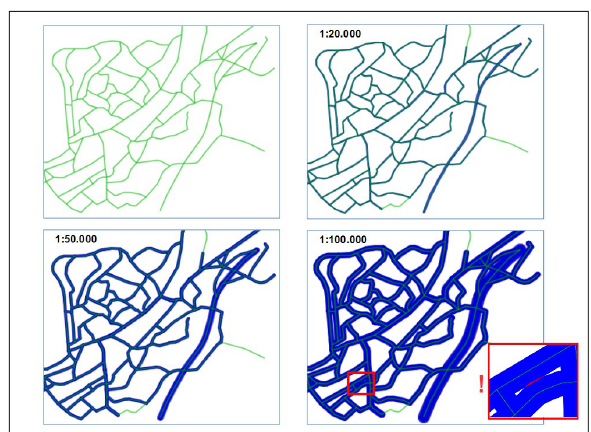
Figure 2. An iterative method to estimate the characteristic representation scale of a cartographic database road network